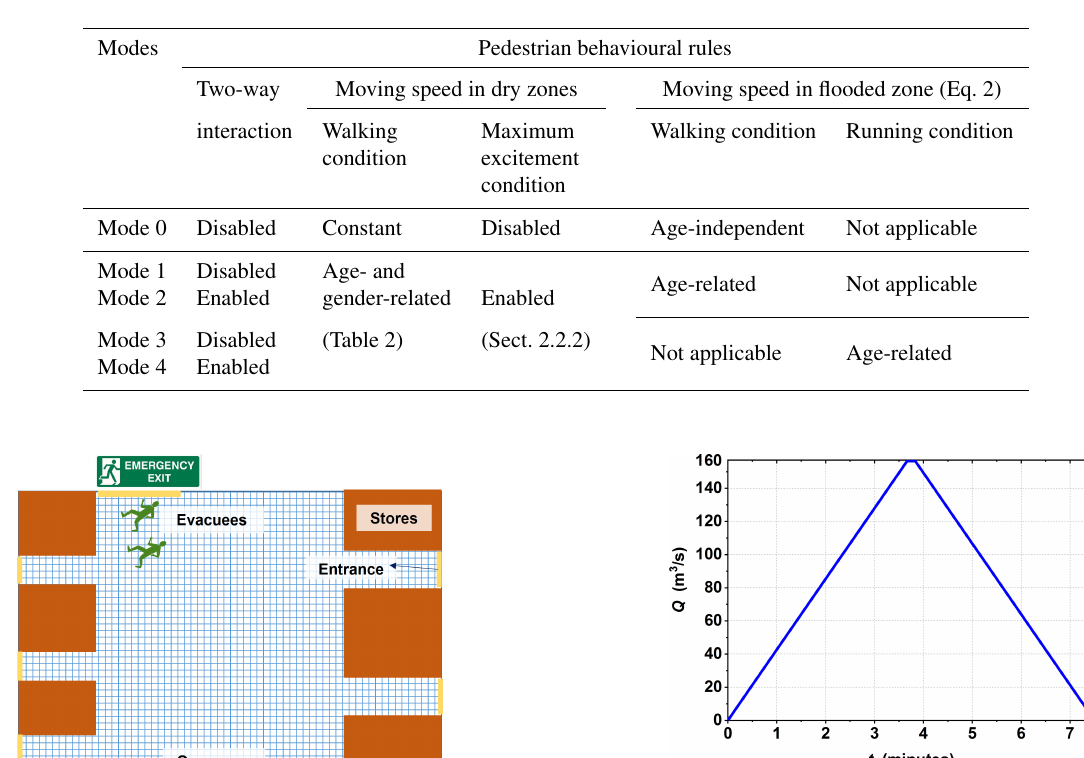
Table 4. Configuration modes used to set up and run the simulator to evaluate the newly added characteristics and rules.